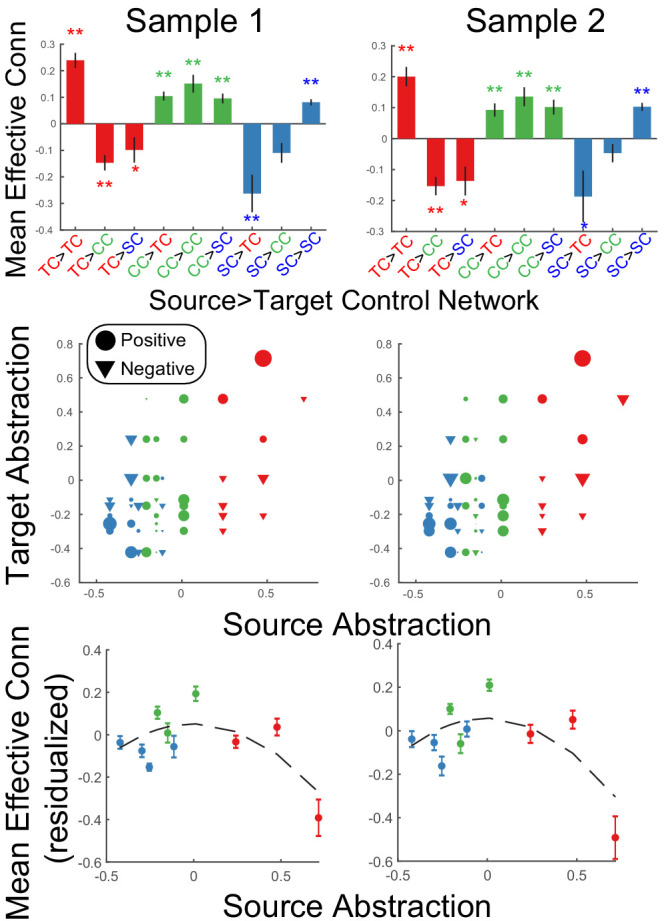
Static network interactions.Top: Effective connectivity was averaged as a function of source>target network. Bars are colored as a function of the source network: TC – temporal control (red); CC – contextual control (green); SC – sensory-motor control (blue). ** denotes Bonferroni-corrected p<0.05. * denotes p<0.05 uncorrected. Middle: Effective connectivity organized by abstraction (first dimension of multi-dimensional scaling depicted in Figure 3). Circles denote positive interactions and inverted triangles denote negative interactions. Markers are scaled by the magnitude of effective connectivity. Markers are colored by the network assignments. Bottom: Data re-depicted to highlight the quadratic effect of source abstraction. Linear effects of target abstraction, source abstraction, and target x source abstraction have been regressed out to isolate the quadratic effect of source abstraction demonstrating that mean (positive) effective connectivity peaks at areas in the middle of the abstraction gradient.